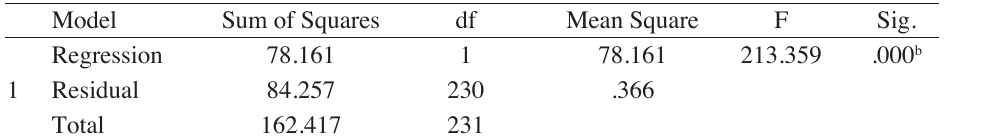
ANOVA (Job Satisfaction and Intention To Leave) Model Sum of Squares